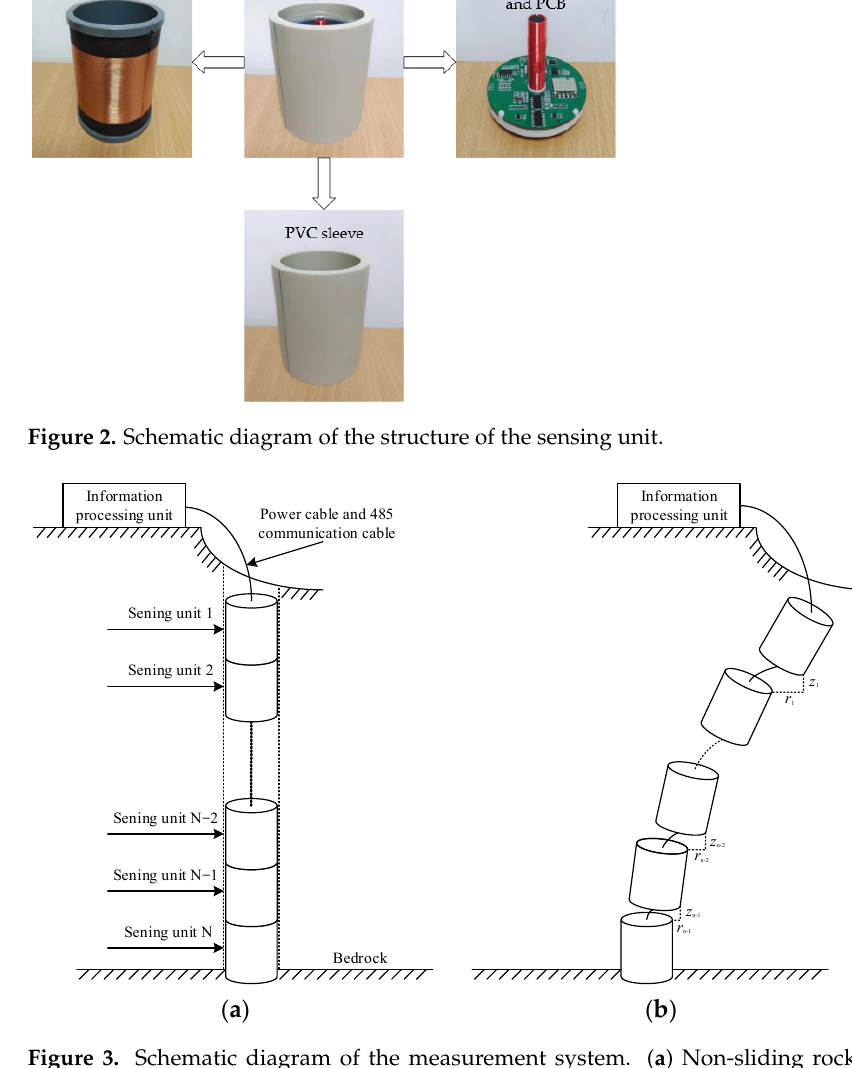
Figure 3. Schematic diagram of the measurement system. ( a ) Non-sliding rock and soil mass; ( b ) Sliding rock and soil mass.